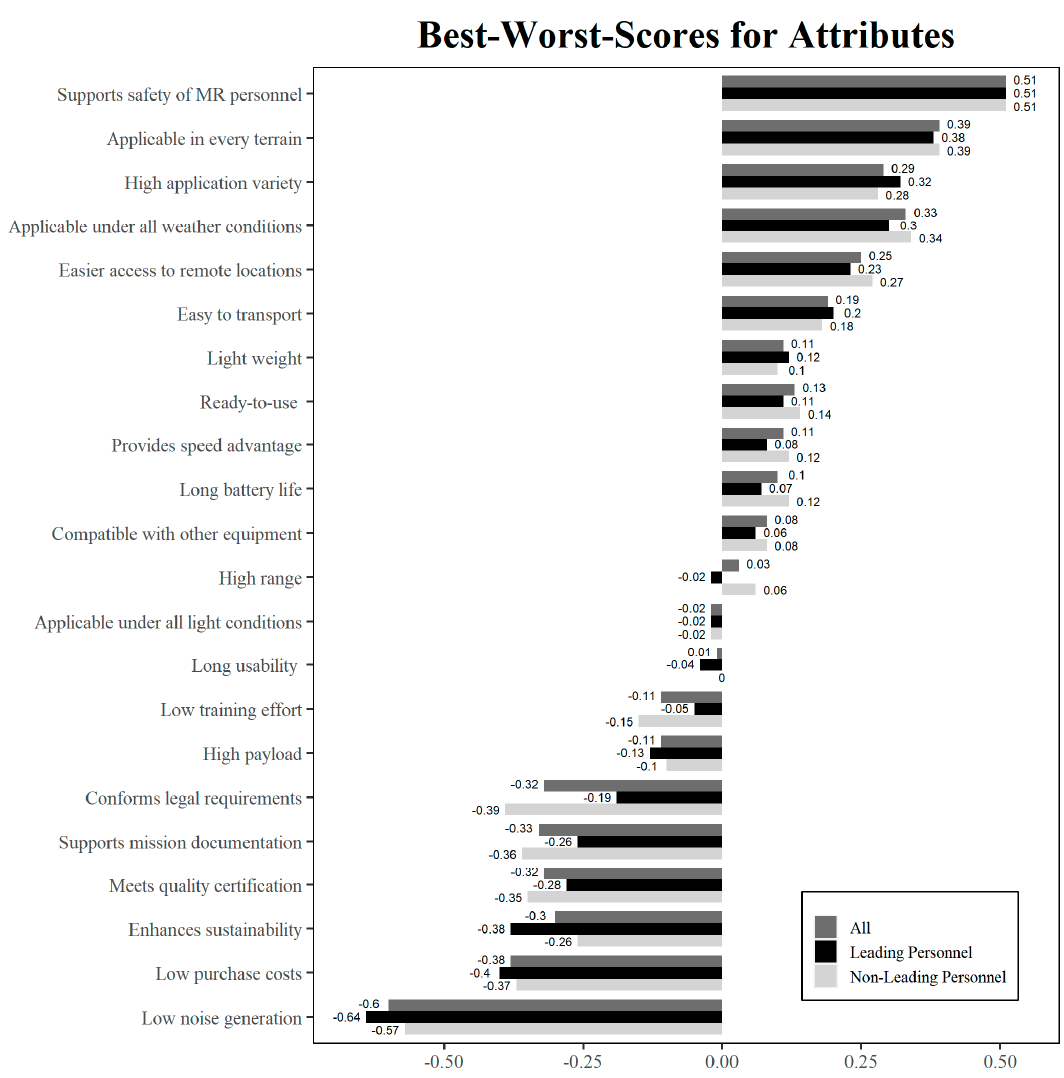
Figure 3. Graphical representation of the best–worst scores.